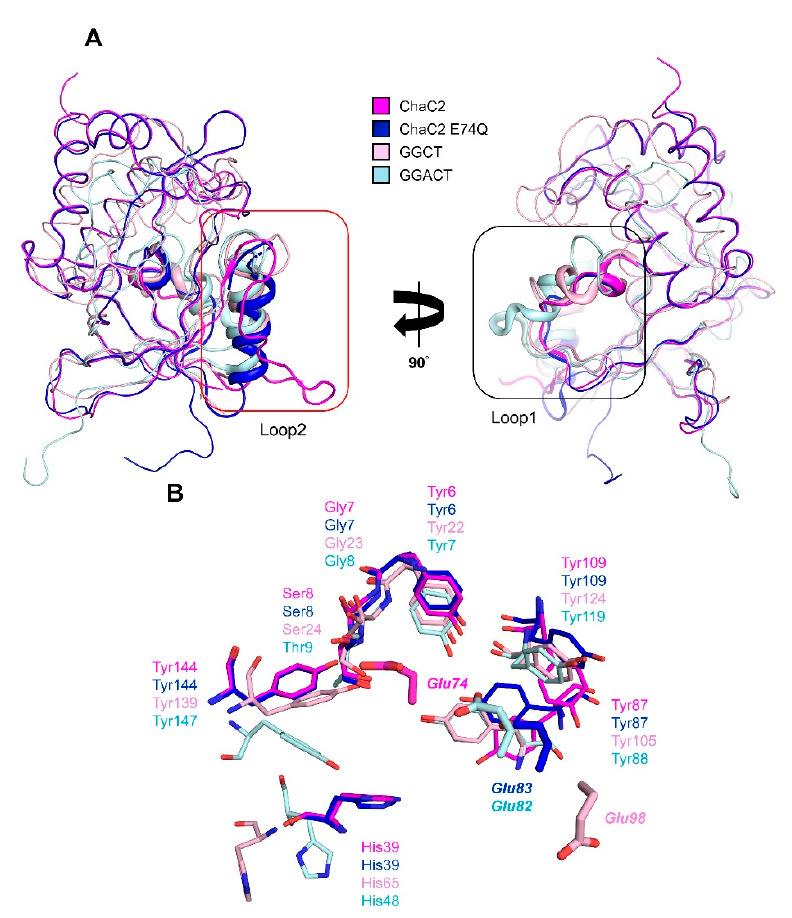
Figure 5. Structural comparison of human ChaC2, human GGCT, and human GGACT. ( A ) The structures of ChaC2 (magenta), ChaC2 E74Q (blue), GGCT (PDB ID: 2RBH, pink), and GGACT (PDB ID: 3JUC, cyan) are superimposed. The loop2 and loop1 regions of ChaC2 are indicated by red (left) and black (right) boxes, respectively. ( B ) The substrate-binding residues of GGCT and GGACT are denoted as pink and cyan stick models, respectively. ChaC2 / ChaC2 E74Q residues overlapped with the substrate-binding residues of GGCT and GGACT are denoted as magnetic / blue stick models.